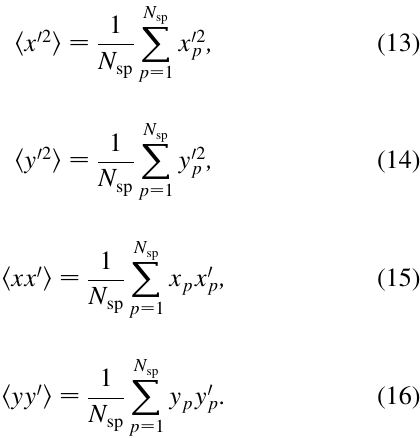
FIG. 5. History of emittance growth with initially WB distributed beam. Solid curve shows the emittance growth ratio with the beam current increase due to the longitudinal compression, and the dashed line indicates one without the compression.